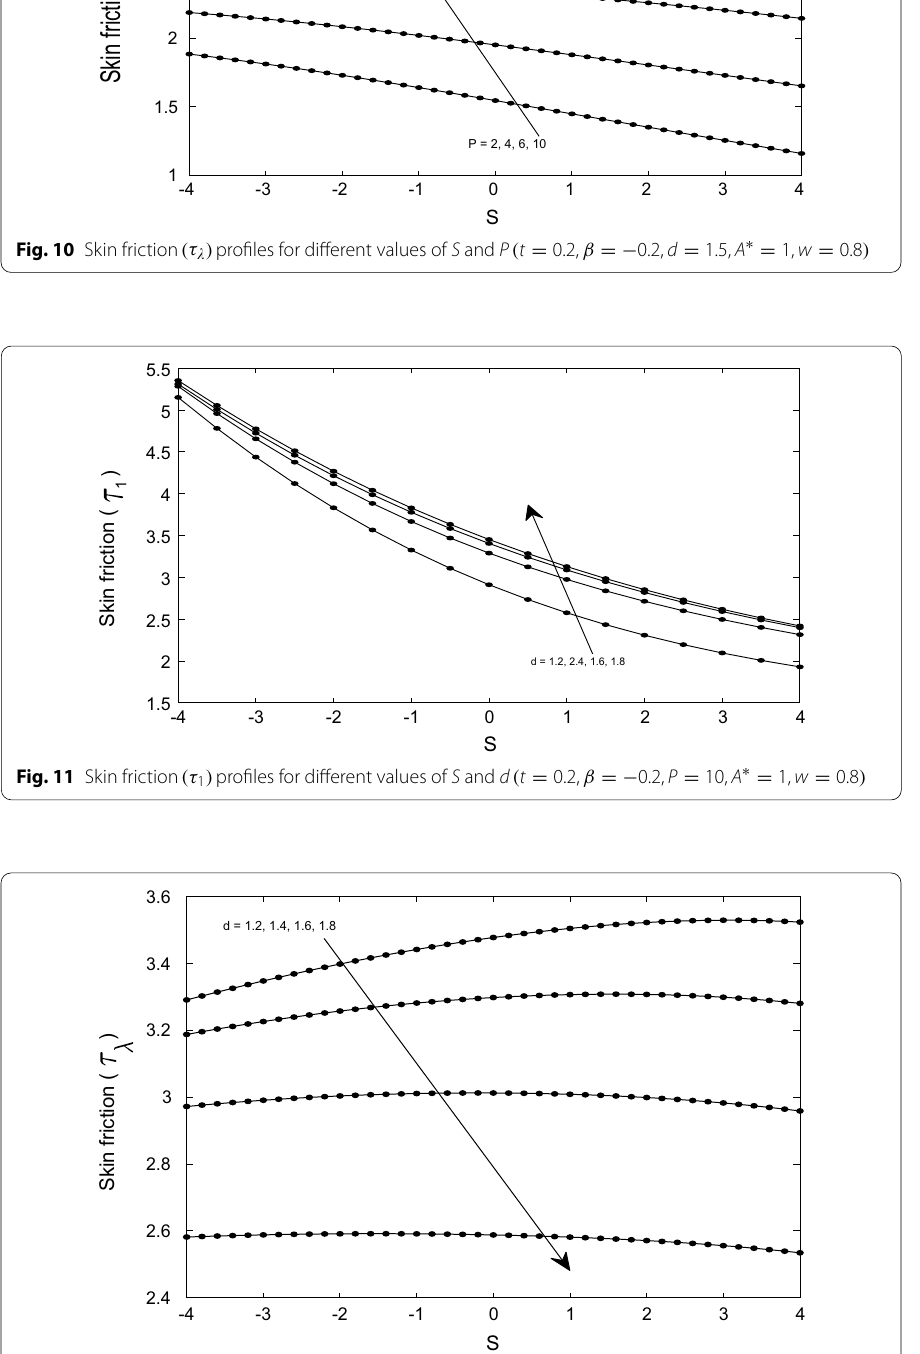
0.2, β 0.2, P 10, A ∗ 1, w 0.8 = = − = = =